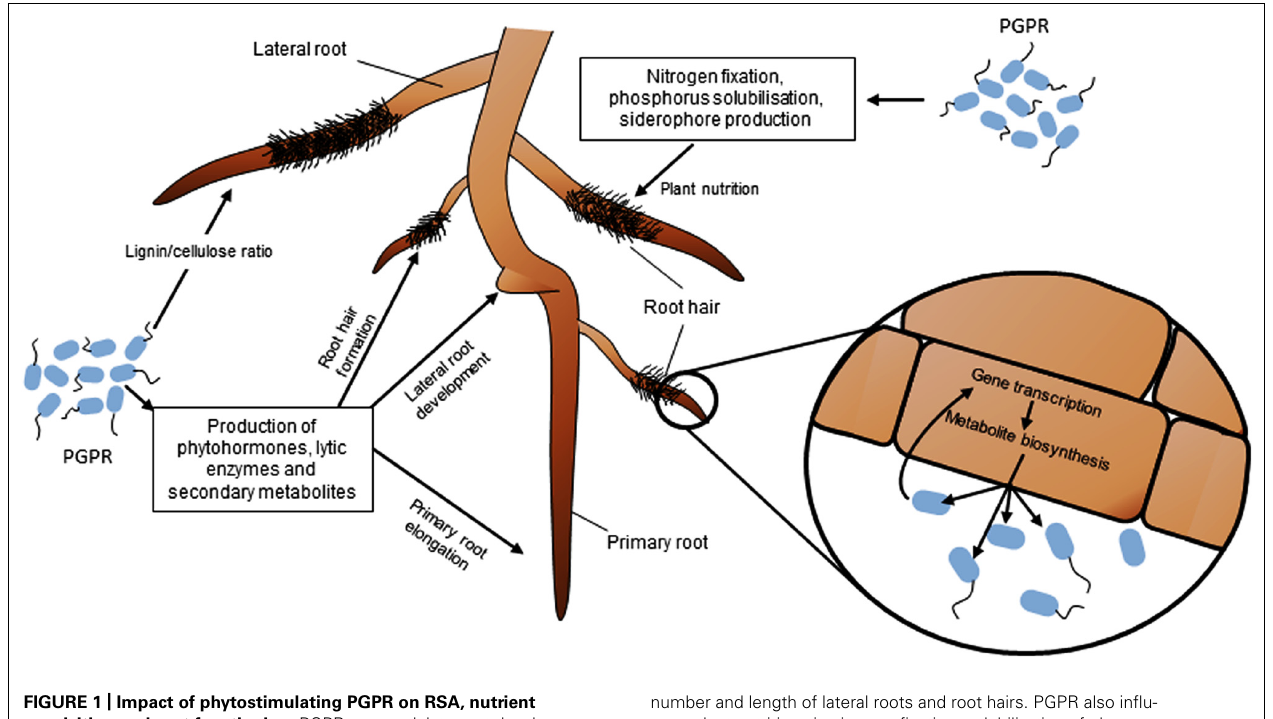
FIGURE 1 | Impact of phytostimulating PGPR on RSA, nutrient acquisition and root functioning . PGPR can modulate root develop- ment and growth through the production of phytohormones, secondary metabolites and enzymes.The most commonly observed effects are a reduction of the growth rate of primary root, and an increase of the